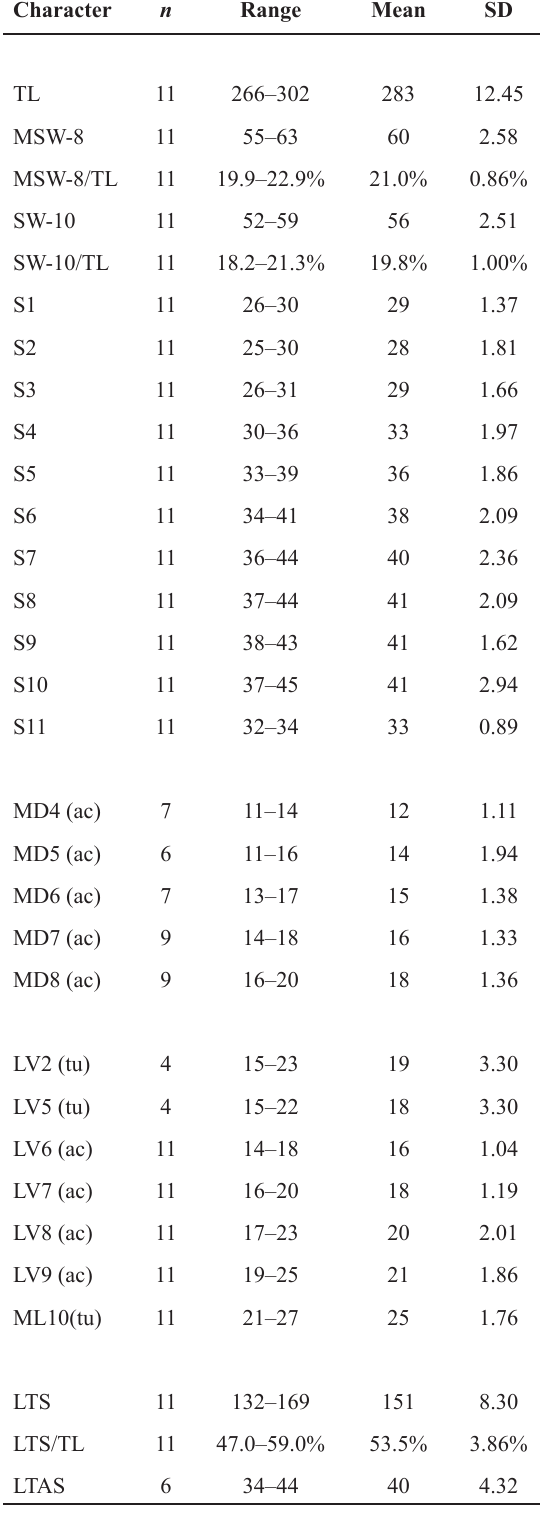
Table 15. Measurements from light microscopy for Echinoderes songae Sørensen & Chang sp. nov. (in µm), including number of measured specimens ( n ) and standard deviation